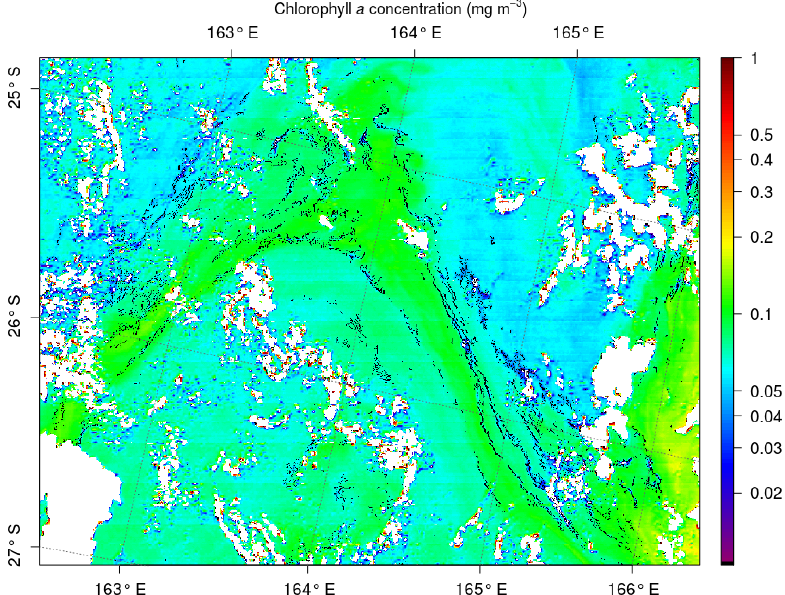
Figure 9. MODIS Aqua image at 250m taken on 6 March 2015 to the south of the OUTPACE cruise, illustrating the structure of the chlorophyll (colors) together with the filaments of Trichodesmium detected by our algorithm (in black). Cloud pixels are in